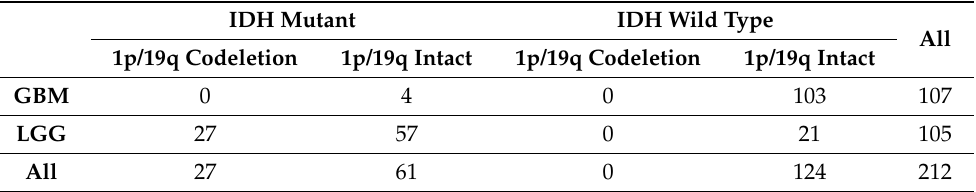
Table 1. Summary of the repartition size of the dataset regarding the tumor grade, IDH mutation status, and 1p/19q codeletion status. Each value represents the number of patients of that glioma type in our dataset. IDH